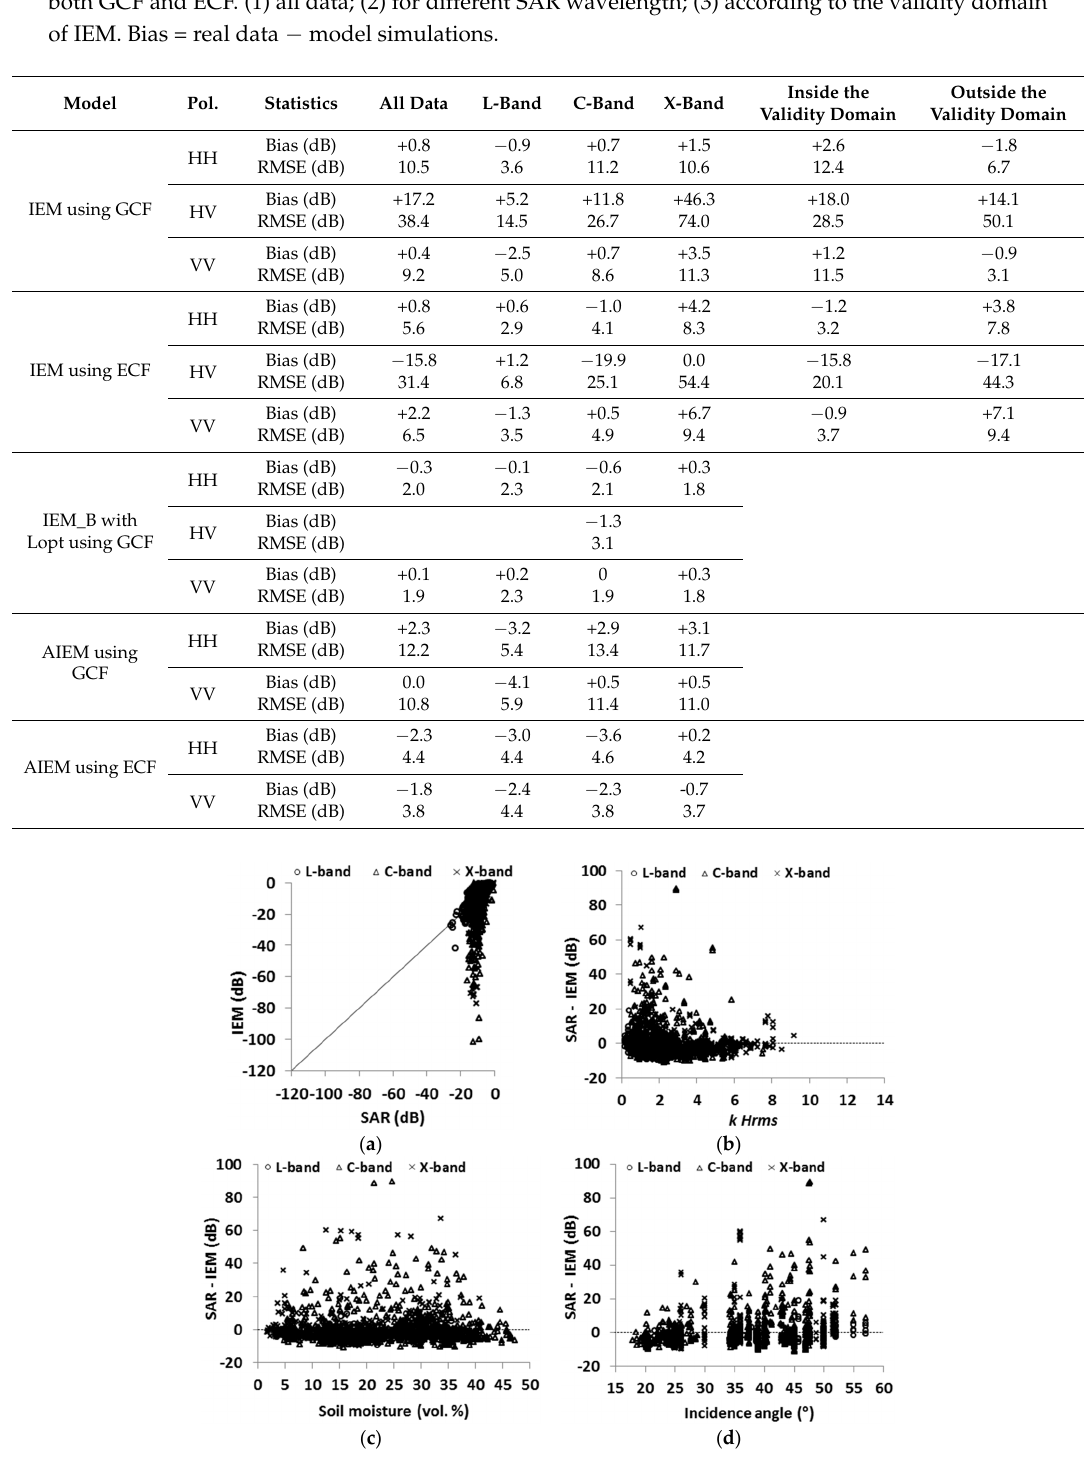
Figure 6. Comparison between backscattering coefficients derived from SAR images and those estimated from IEM at HH polarization using GCF. ( a ) IEM simulations vs. SAR data; ( b ) difference between SAR signal and IEM vs. soil roughness ( kHrms ); ( c ) difference between SAR signal and IEM vs. soil moisture ( mv ); ( d ) difference between SAR signal and IEM vs. incidence angle.